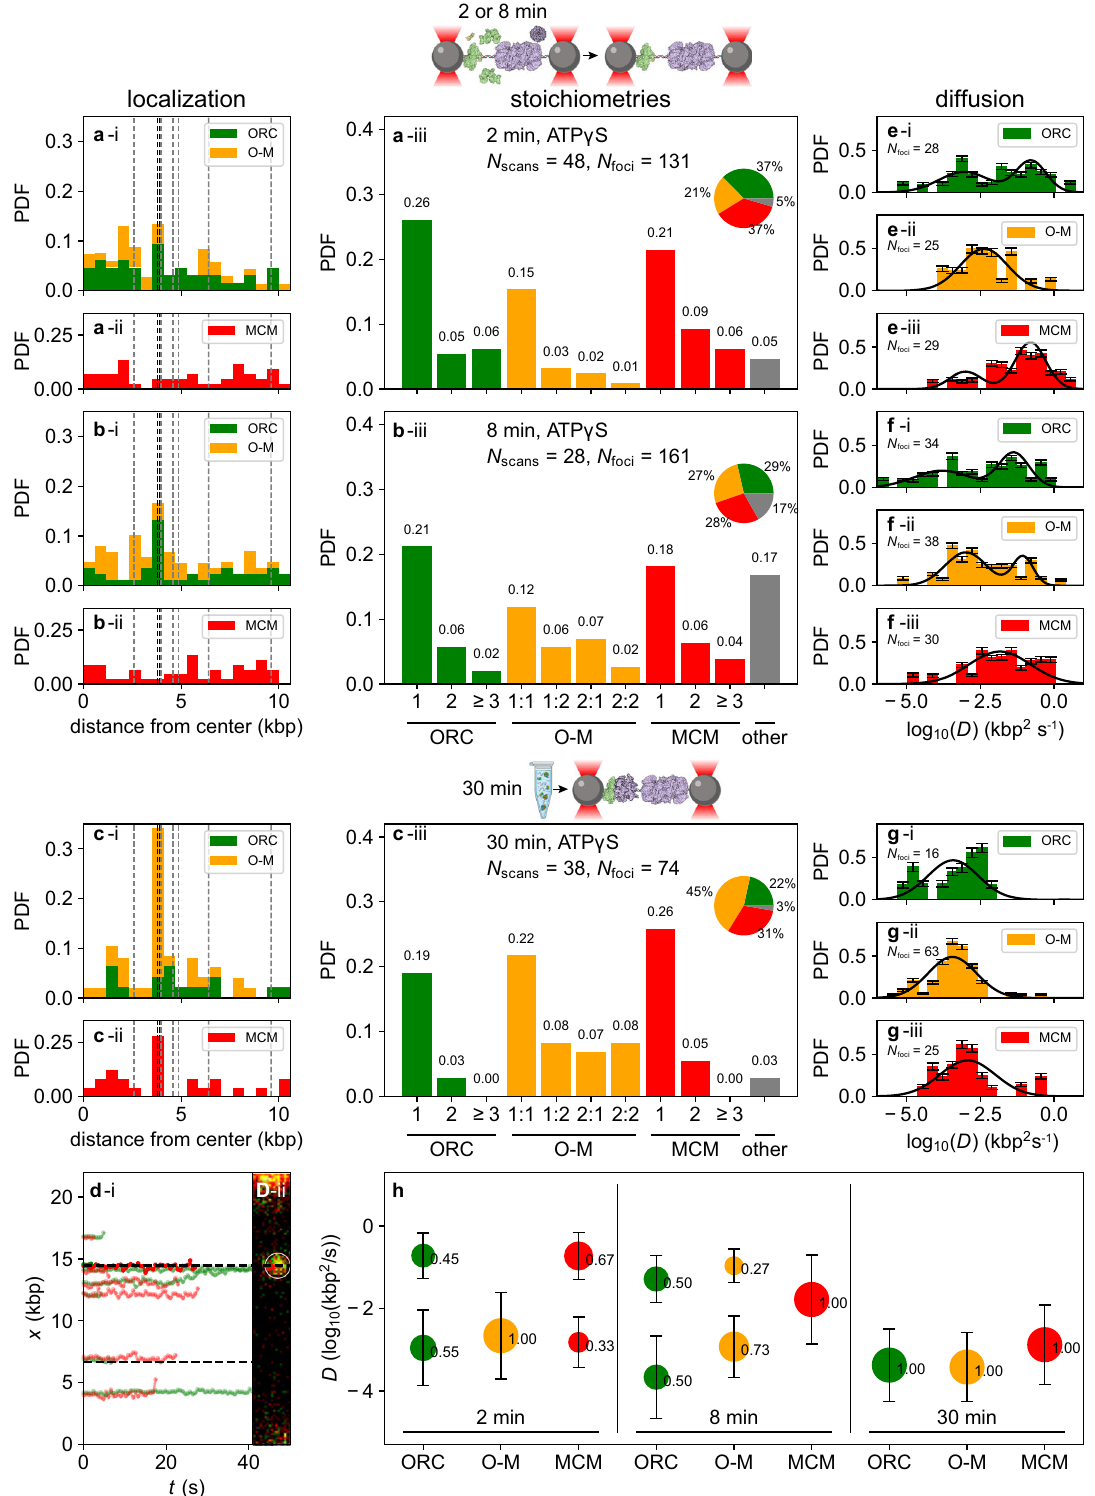
(Fig. 3e – ii, f – ii), although the distribution in Fig. 3e – ii could only be fi t to a single, slowly diffusing population (Fig. 3h). Traces showing the colocalization (and movement) of ORC and MCM over extended periods of time are depicted in Fig. 3d (see also Supplementary Movie 3). Interestingly, following short incuba- tion times, nearly all recruited MCM molecules that were not colocalized with ORC were highly mobile, with a mean diffusion